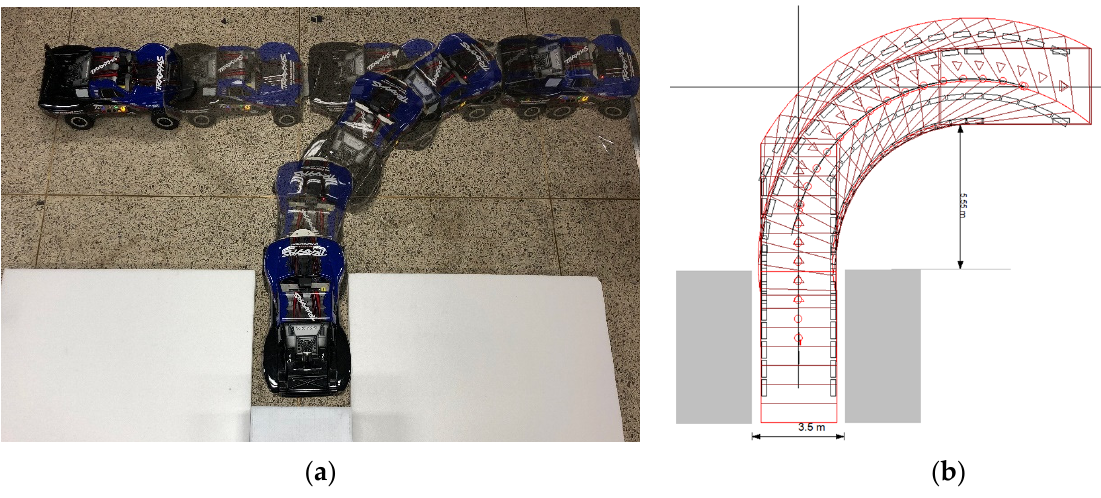
Figure 11. Success of ( S + R − S − ) perpendicular parking with appropriate separation ∆ Y : ( a ) Experi- mental parking test; ( b ) simulated parking path.